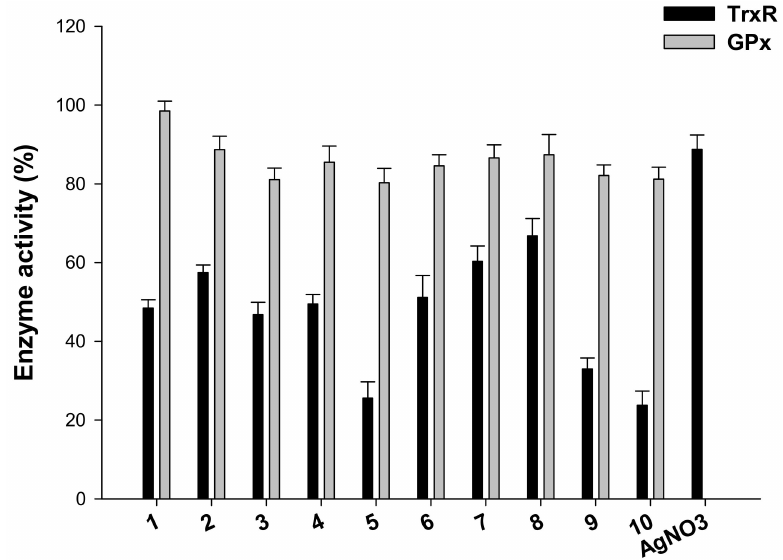
Figure 4. E ff ects of compounds 1 – 10 and AgNO 3 on redox enzymes in human ovarian cancer cells. The 2008 cells were incubated for 18 h with tested compounds. Subsequently, cells were washed twice with Phosphate Bu ff er Solution (PBS) and lysed. TrxR activity was tested by measuring NADPH-dependent reduction of DTNB and glutathione peroxidase (GPx) activity was followed at 340